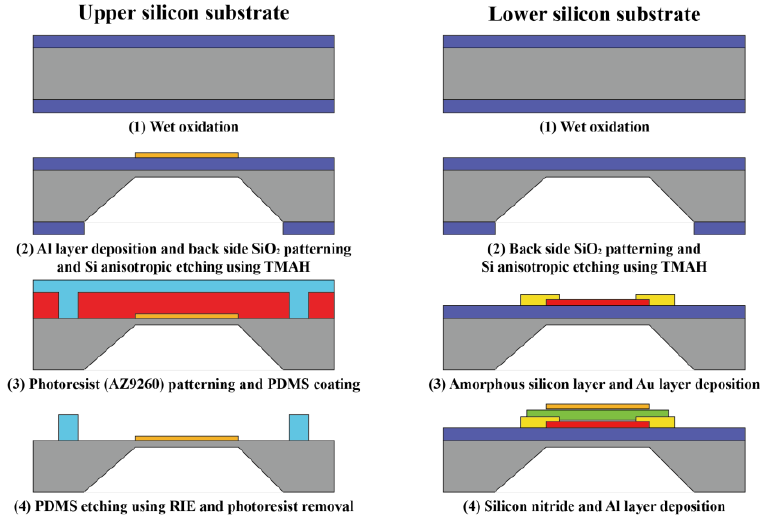
Figure 1. Tunable Fabry-Perot interferometer (TFPI) fabrication processes of upper and lower